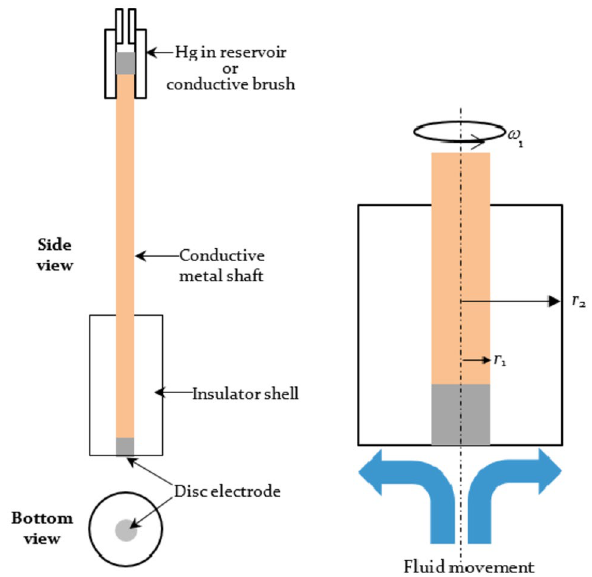
Fig. 3 Schematic illustration of rotating disc